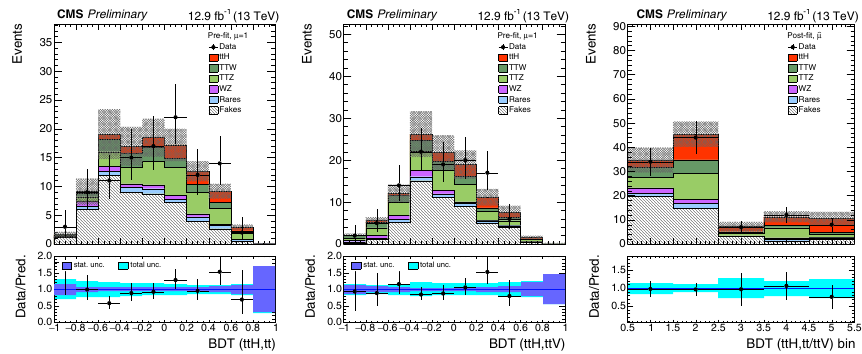
Figure 11. At least three leptons channel: distributions of the BDT classifier outputs shown before the sig- nal extraction fit (x2), trained against t¯t (left) and t¯tV (middle). Post-fit distributions and uncertainties of the combination of the BDT classifier outputs in the bins used for signal extraction (right)